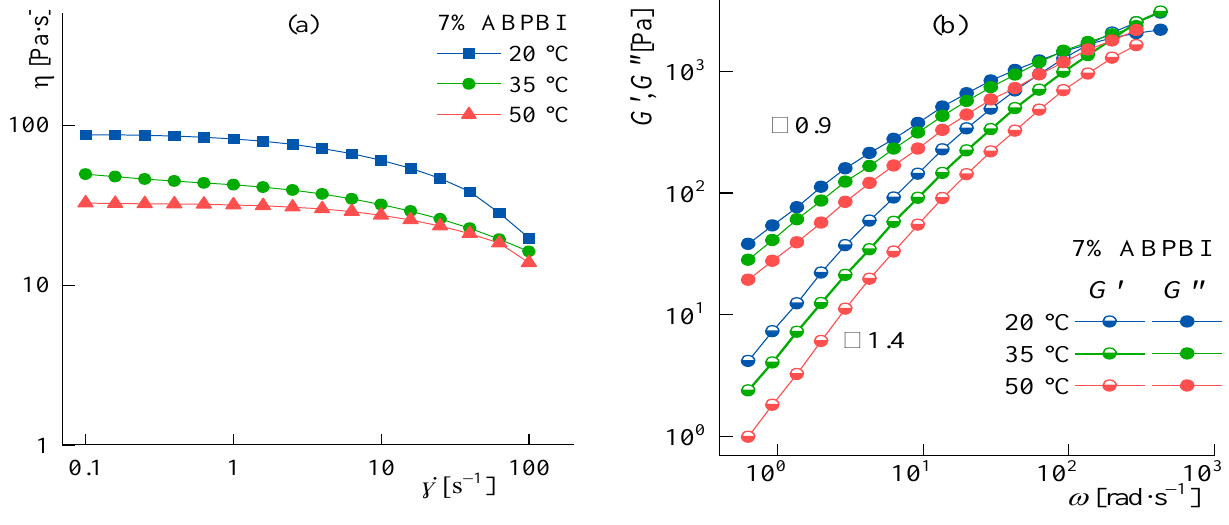
Figure 10. Flow curves ( a ); and frequency dependences of the elastic and loss dynamic moduli ( b ) for 7% solution in a solvent with DMSO:MeOH ratio of 9:1. The slope values in the terminal zone are indicated in the graphs.